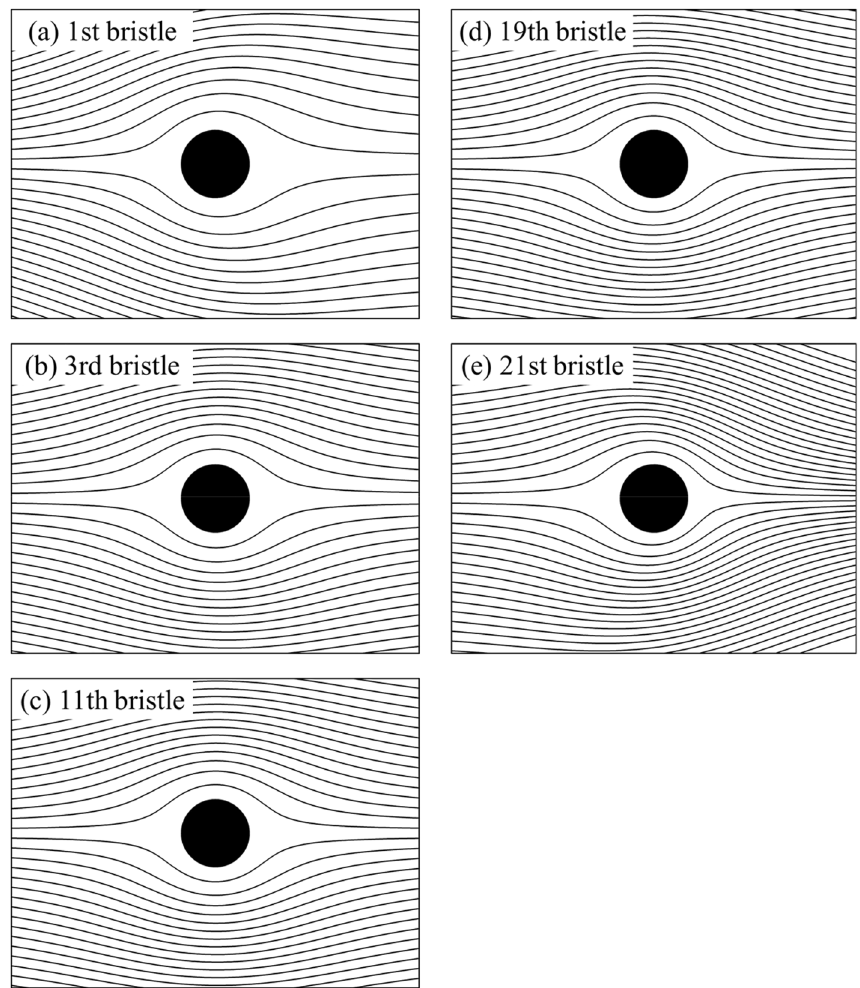
Figure 9. Streamline pattern of ( a ) the first, ( b ) the third, ( c ) the eleventh, ( d ) the nineteenth, and ( e ) the twenty-first bristle of a single bristled